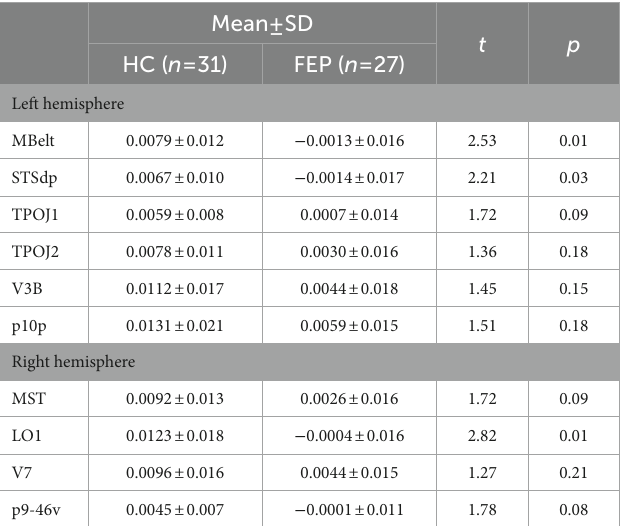
TABLE 3 Connectivity changes with